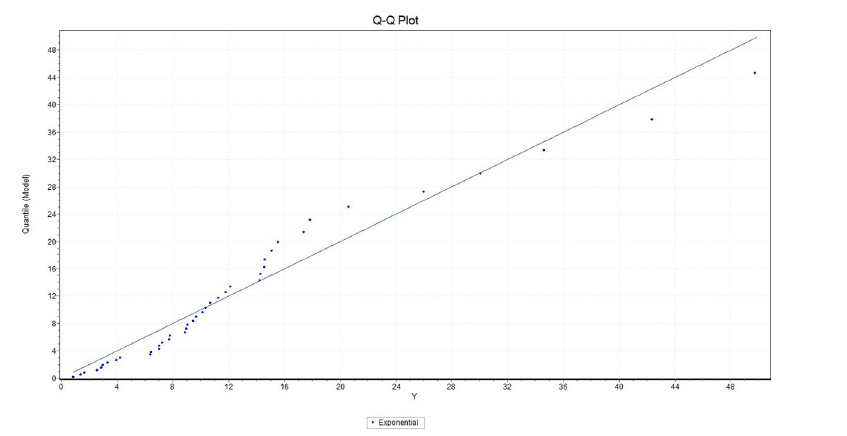
Fig 4. Plot of the empirical quantile of exponential distribution fitted to the Y data set.